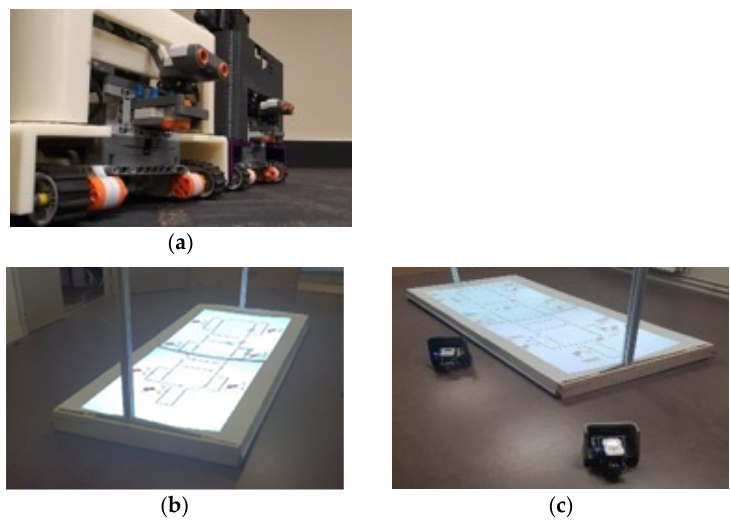
Figure 2. ( a ) Mobile robots. ( b ) The physical model of the production cell. ( c ) Mobile robots around the physical model of the production cell.